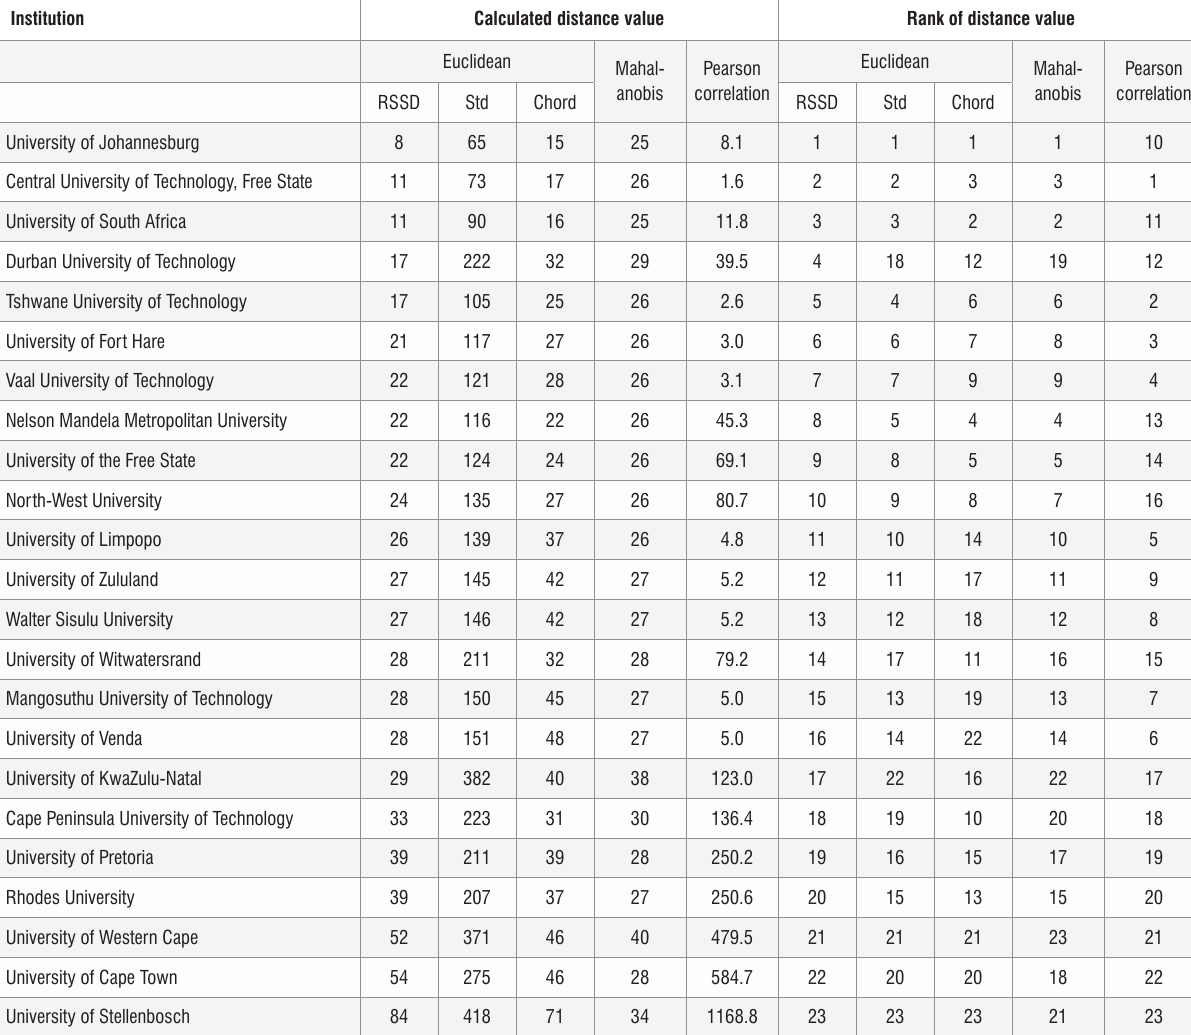
Table 2: Comparison of five distance measures using only race percentages benchmarked against national norms Calculated distance